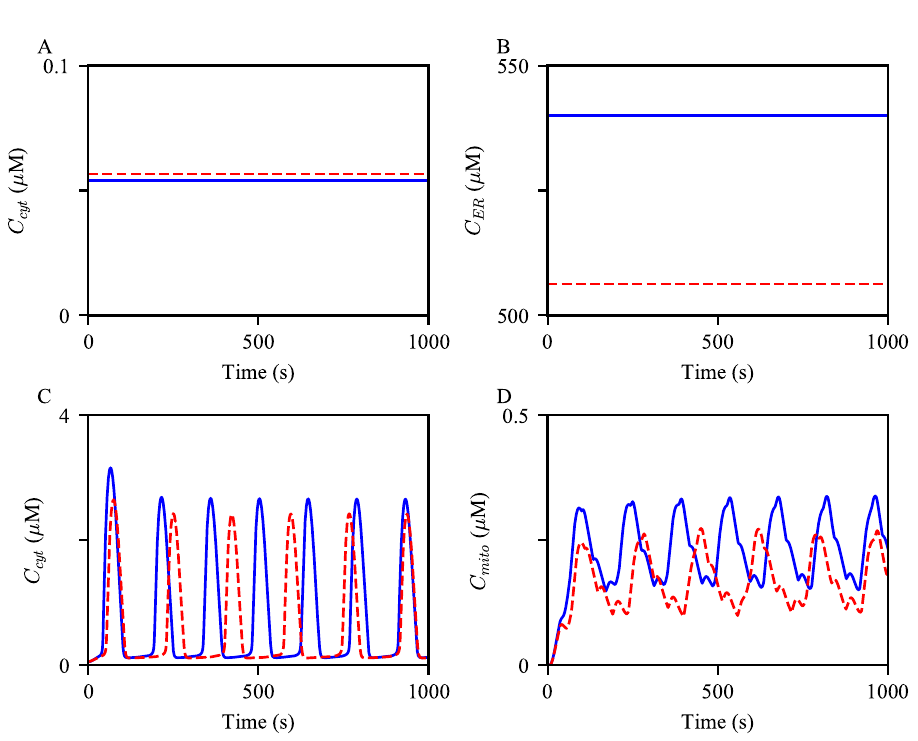
Fig 12. Effects of decreased net SERCA flux on the steady state Ca 2+ concentrations and Ca 2+ oscillations. Ca 2+ concentrations in (A) the cytosol and (B) the ER at the steady state, P s = 0 μ M, simulated from the control model (in blue) and the model with increased � k (in red). Oscillations of (C) cytosolic, (D) mitochondrial Ca 2+ concentrations generated from the control model, in blue, and with the increased � k , in red dashed. The model was given continuous stimulation of IP 3 with P s = 0.3 μ